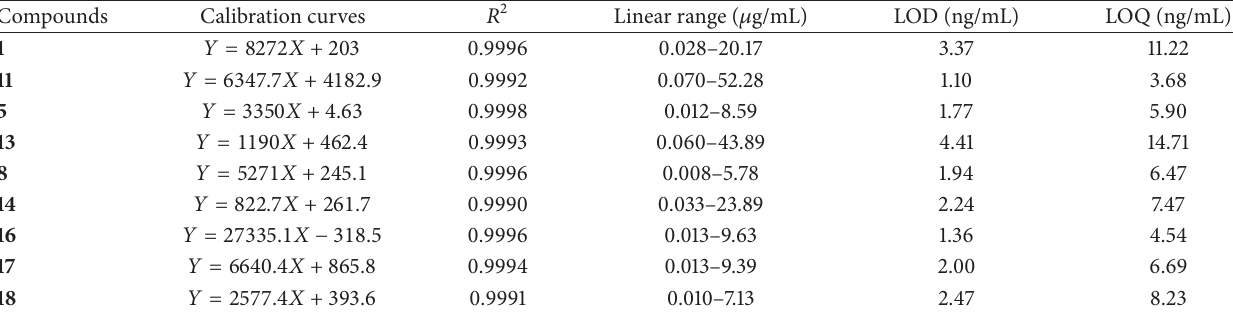
Figure 5: MS and MS/MS spectra of compounds 10 , 11, and 13 . ((a) MS spectrum of 11 ; (b) MS spectrum of 13 ; (c) MS/MS spectrum of [M–H] − of 13 , CE 35 V; (c 󸀠 ) MS/MS spectrum of [M–H] − of 13 , CE 70 V; (d) MS/MS spectrum of [M+HCOO] − of 13 , CE 35 V; (d 󸀠 ) MS/MS spectrum of [M+HCOO] − of 13 , CE 70 V; (e) MS/MS spectrum of [M–H] − of 10 , CE 35 V; (e 󸀠 ) MS/MS spectrum of [M–H] − of 10 , CE 70 V; (f) MS/MS spectrum of [M+HCOO] − of 11 , CE 35 V; (f 󸀠 ) MS/MS spectrum of [M+HCOO] − of 11 , CE 70 V; (g) MS/MS spectrum of [M–H] − of 12 , CE 35 V; (g 󸀠 ) MS/MS spectrum of [M–H] − of 12 , CE 70 V). Table 3: Calibration curves, LOD, and LOQ of nine compounds.